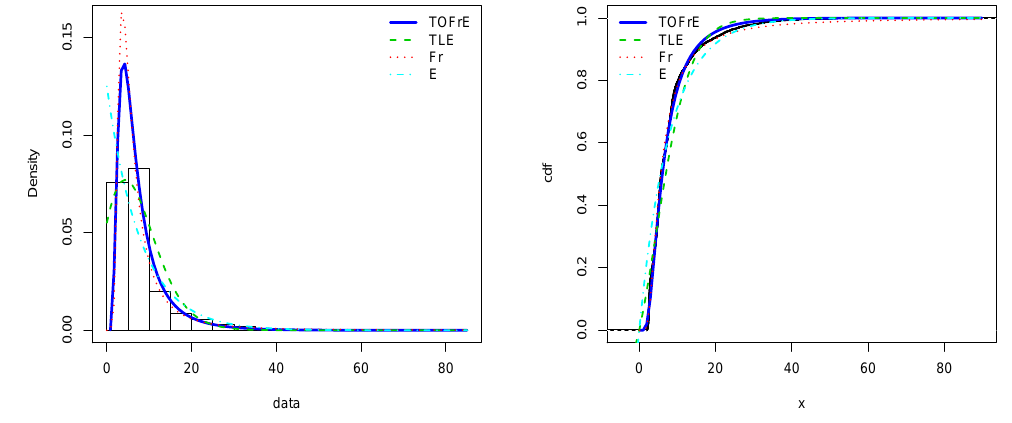
Figure 8. Plots of all the estimated pdfs and cdfs for Data set